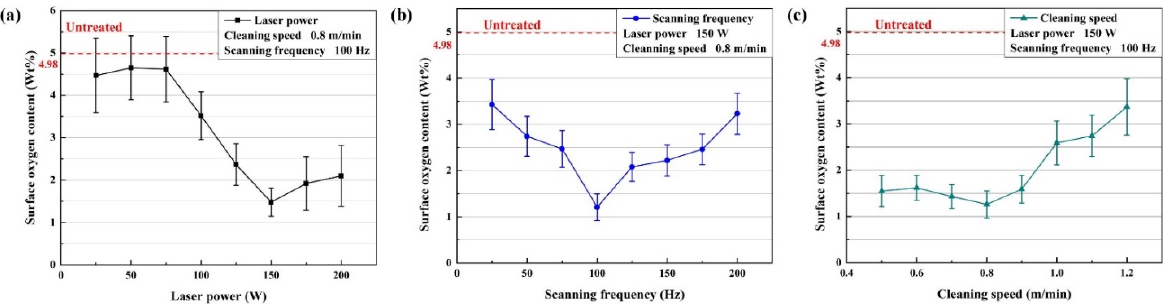
Figure 2. The variation of the surface oxygen content with the process parameters: ( a ) laser power; ( b ) scanning frequency; ( c ) cleaning speed.